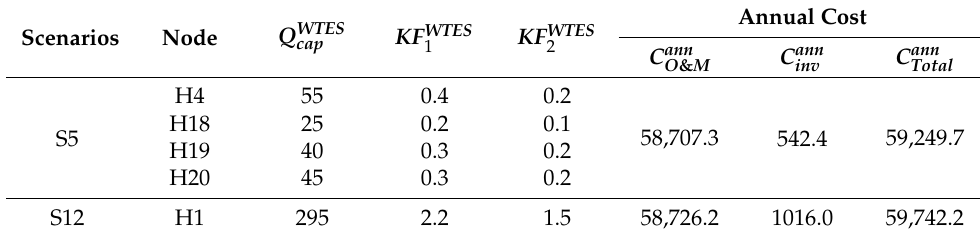
Table 9. Optimization results of configuration schemes S5 and